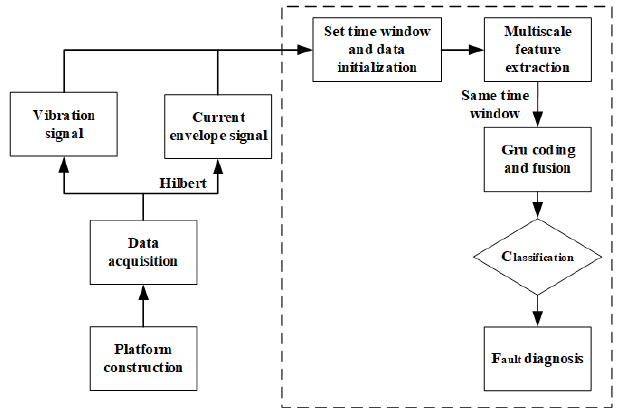
Figure 1. Overview